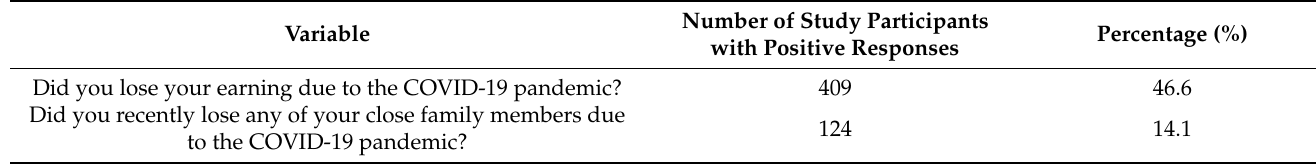
Table 2. Impact of COVID-19 on the study population (N = 878).